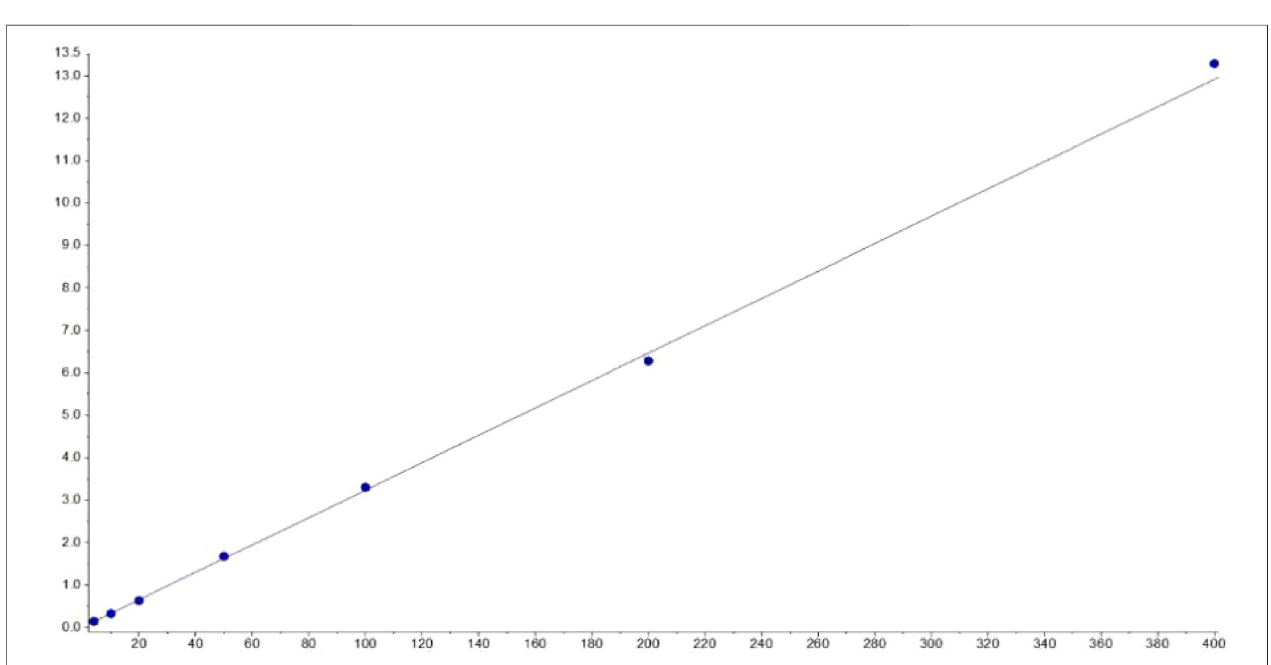
FIGURE 7 | The linearity of the calibration